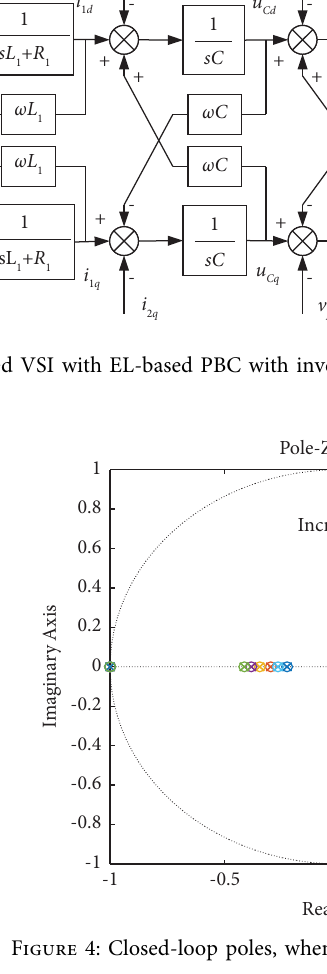
1 is increased from 0 to